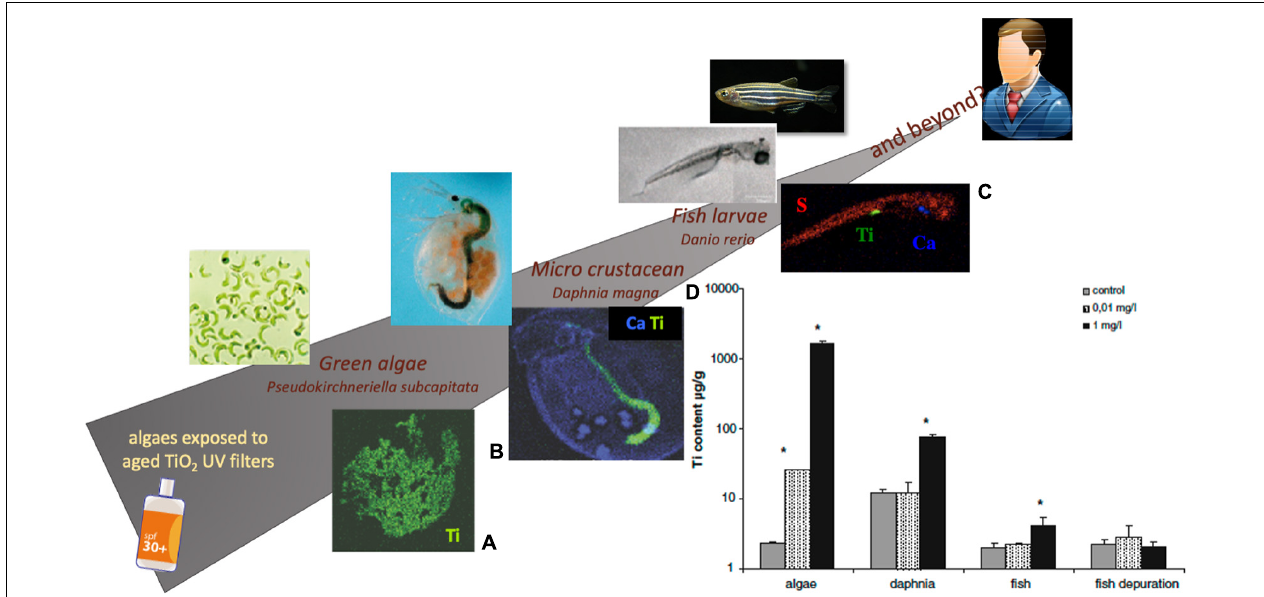
FIGURE 6 | Example of trophic transfer of an aged nano-TiO 2 UV-filter, from green algae to micro-crustacean and fish. Elemental mapping of the internalized Ti element after exposure was achieved on P. subcapitata (A) , the D. magna (B) , and the D. rerio larvae (C) , using X-ray microfluorescence. Ca and S maps were also superimposed in Daphnia and D. rerio in order to visualize the entire body. Ti quantification in these organisms as a function of the exposure concentration, was realized by ICP-MS analysis coupled to total digestion (D) (Fouqueray et al., 2012, 2013).